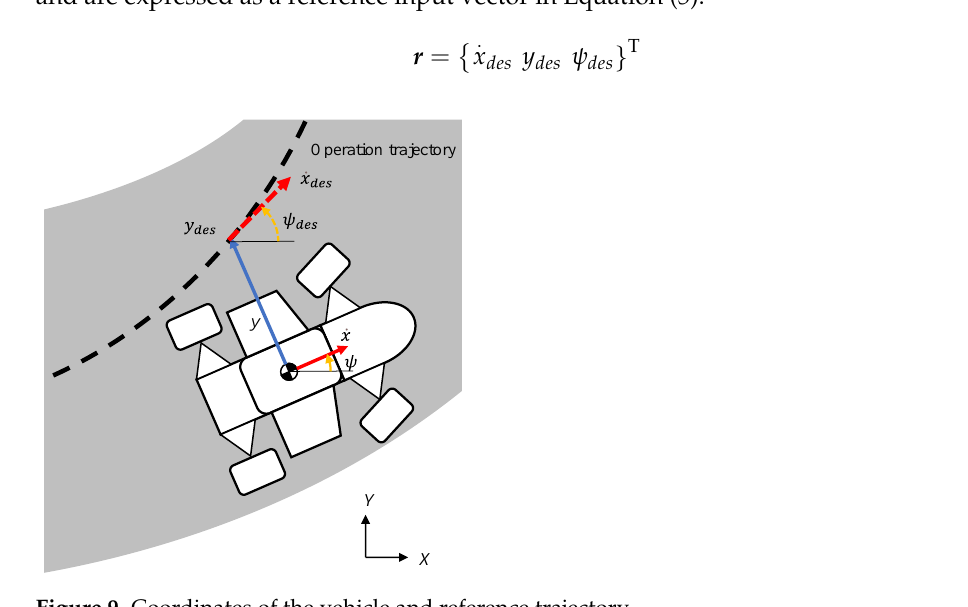
Figure 9. Coordinates of the vehicle and reference